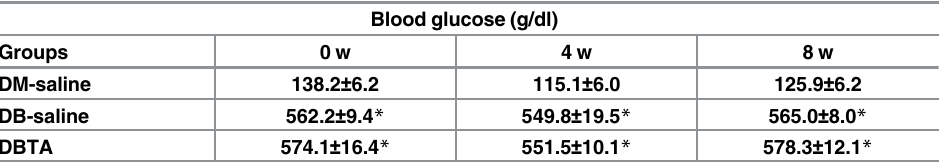
Table 2. Effect of tadalafil on blood glucose.